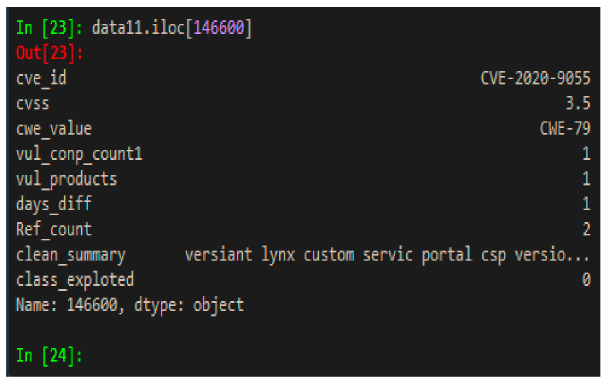
Figure 3. Final data features.